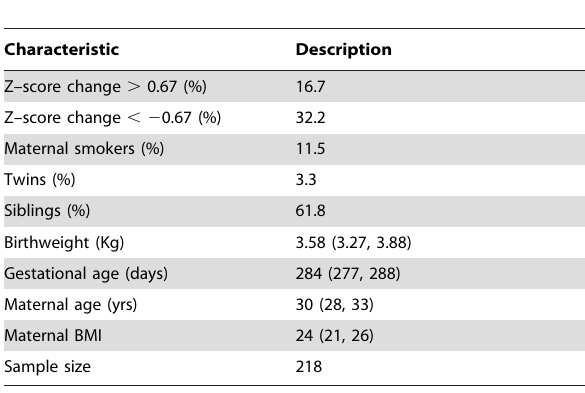
Table 1. Descriptive characteristics of study